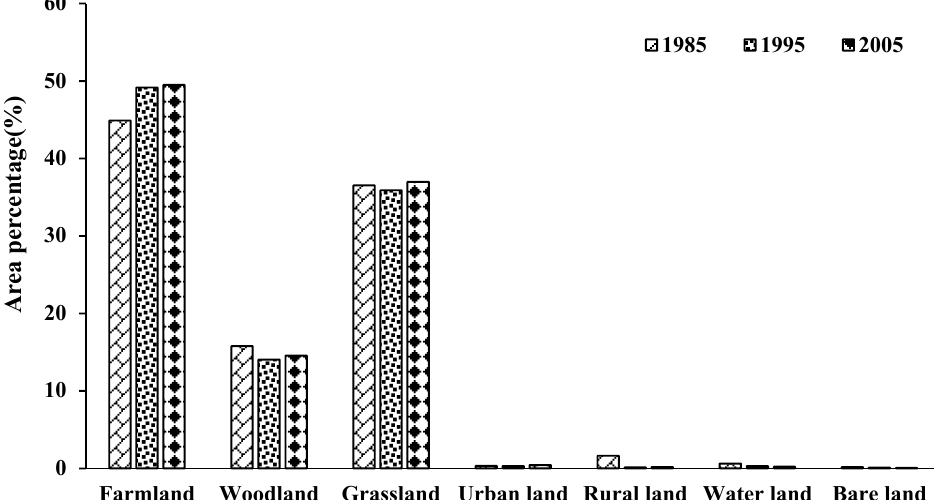
Figure 7. Area percentages of land cover types during the three periods.